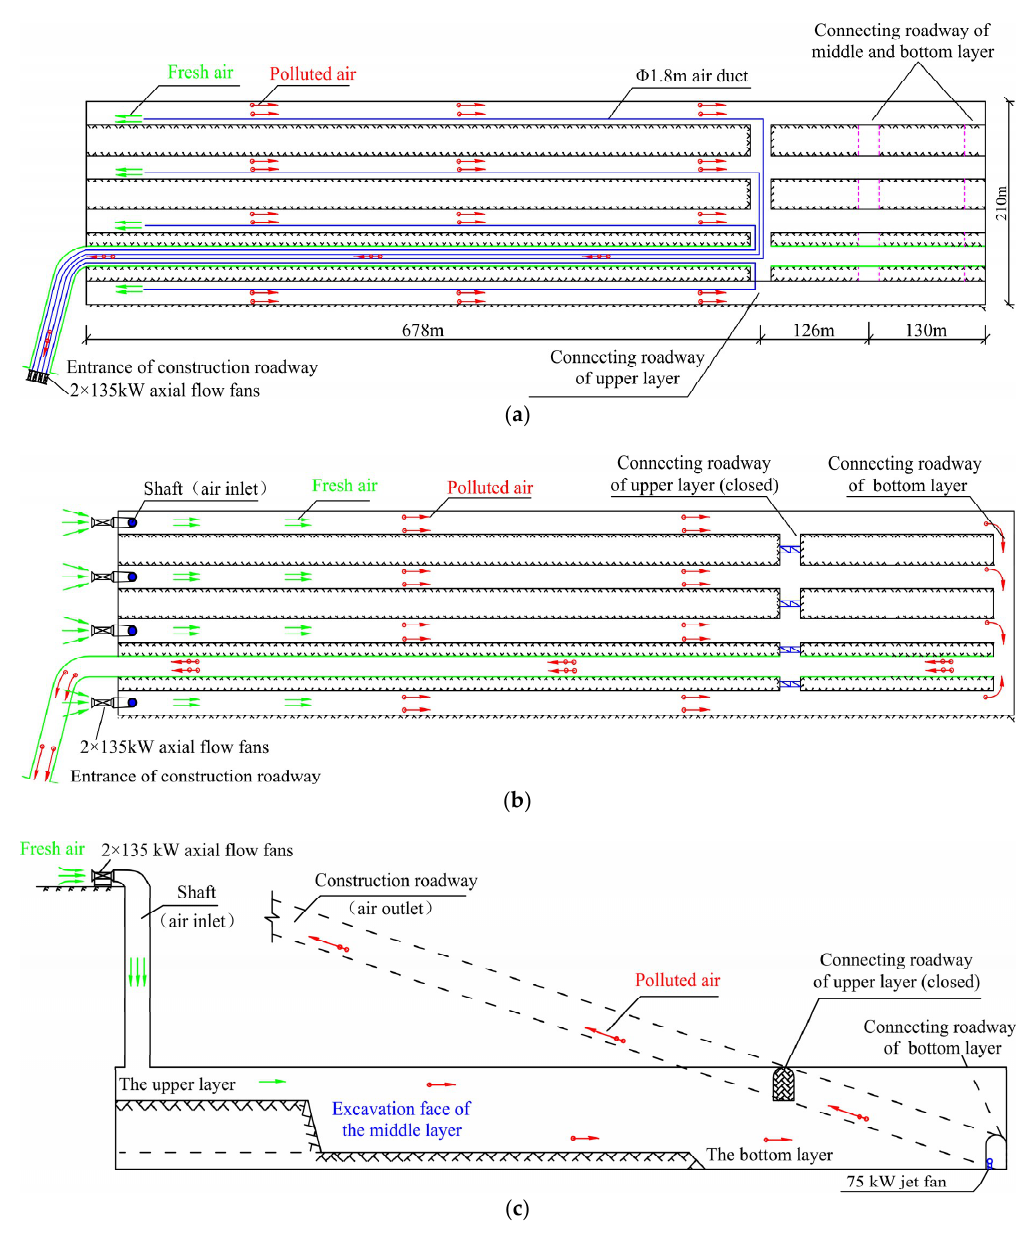
Figure 2. ( a ) The plan for the forced ventilation scheme; ( b ) The plan for axial-flow gallery ventilation scheme; ( c ) The profile of the axial-flow gallery ventilation scheme.